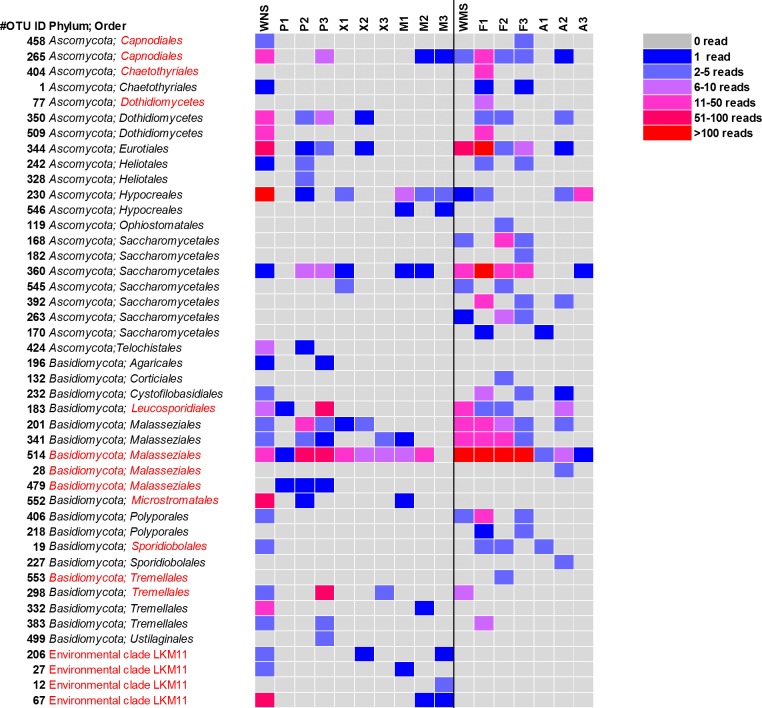
Heatmap of fungal OTUs in North Sea sponges and Mediterranean Sea sponges.OTUs that were only found in seawater and singletons are not shown. Taxonomic affiliation is shown at phylum level and order level whenever possible. Some OTUs (in red) were re-classified based on Bayesian phylogenetic analysis (see also Fig. 4). WNS, North Sea water; P, Halichondria panicea; X, Haliclona xena; M, Suberites massa; WMS, Mediterranean seawater; F, Petrosia ficiformis; A, Aplysina aerophoba. Numbers 1, 2 and 3 refer to different individuals of the sponge species.